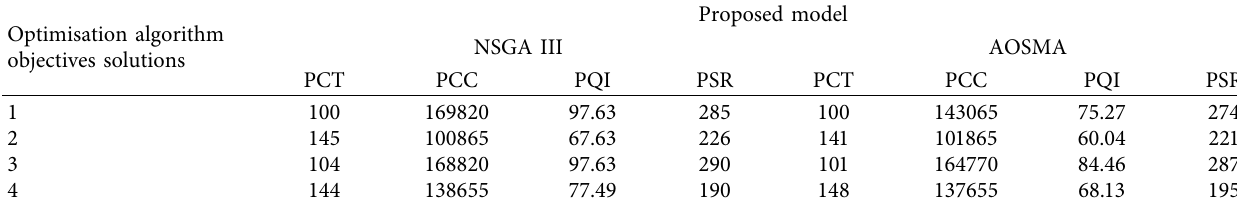
Table 8: LHS-based NSGA III and AOSMA result comparison for case 2.